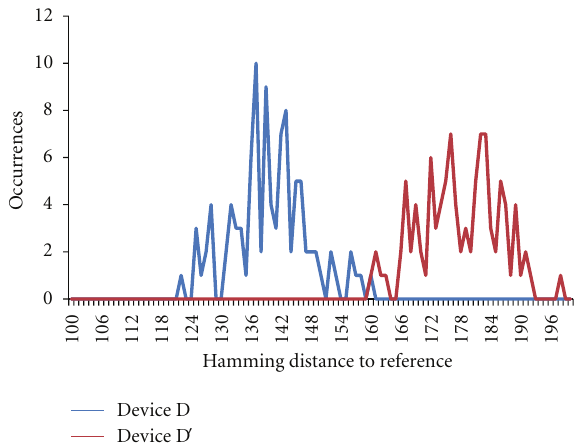
Figure 6: Distribution of Hamming distances to the device D reference stream ρ D (generated from the unconfigured device data Θ D ) for 1000 test data streams from the unconfigured ( ( τ 1 , ... , τ 1000 )) and configured ( T X = ( τ 1 X X